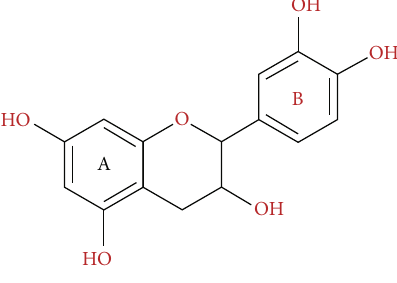
Figure 5: Procyanidin monomer